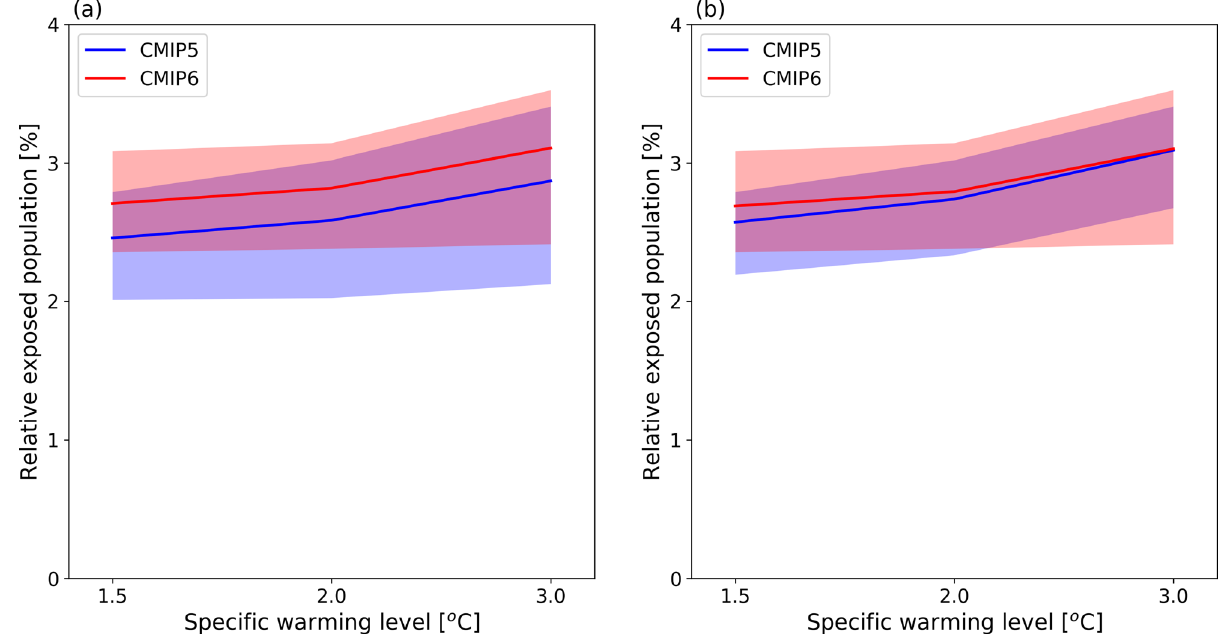
Figure 4. Model robustness for flood exposure. ( a ) Fraction of the global population exposed to potential floods using CMIP5 and CMIP6 corresponding to a SWL relative to the preindustrial period. The mean and maximum and minimum ranges among AOGCMs (lines and shaded area, respectively) are shown. ( b ) As ( a ), but for a subset of 6 models from 6 institutions participating in both CMIP5 and CMIP6 (Supplementary Tables S1 and S2). The population distribution is fixed at the 2015